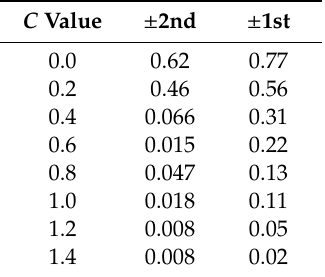
Table 2. High order’s relative intensity according to the C value.